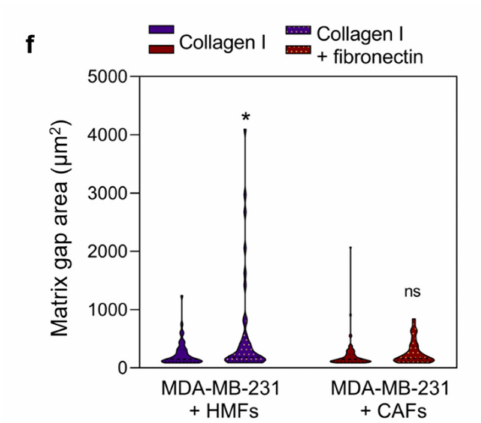
Figure 4. Matrix visualization via second harmonic generation (SHG) imaging. ( a ) Schematic of the process. ( b – e ) Collagen fibers are depicted in cyan, whereas cells appear in magenta. Collagen degradation and remodeling are observed in the form of gaps in the matrix. In co-culture with HMFs, imaging was performed in the collagen matrix ( b ) and fibronectin-rich matrix ( c ). In co-culture with CAFs, imaging was performed in the collagen matrix ( d ) and fibronectin-rich matrix ( e ). ( f ) Quantification of matrix gap area. The Violin plots represent the distribution of the data with the average and SD, n = at least four individual devices. * p ≤